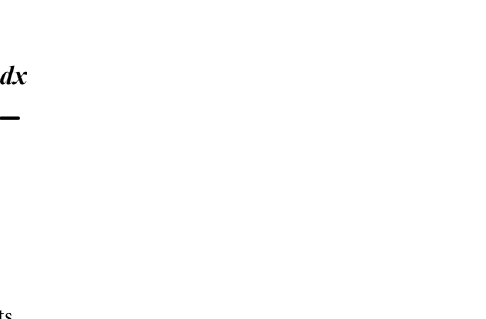
Figure 3. Micro-segment with concentrated